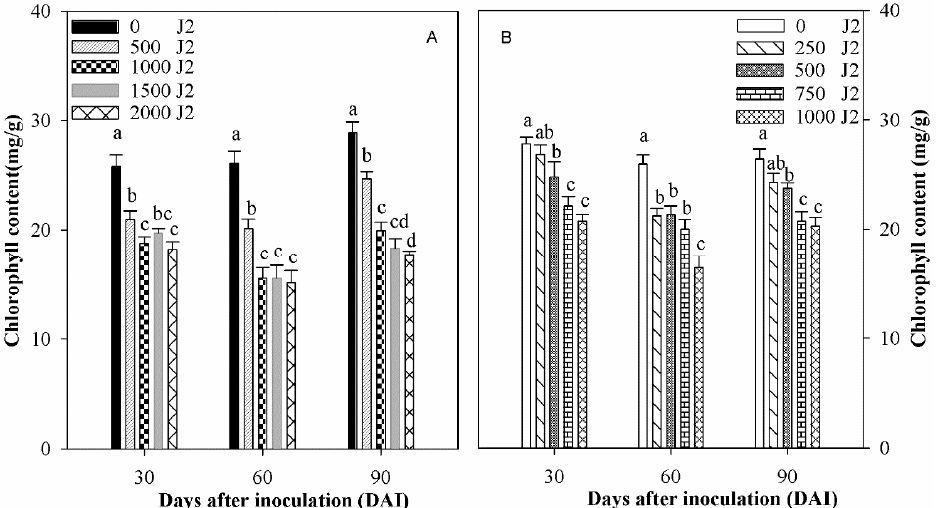
Figure 2. Chlorophyll content of rice leaf during 30-90 DAI with different inoculum densities of M. graminicola J2. ( A ): chlorophyll contents of rice leaf in the first experiment; ( B ): chlorophyll contents of rice leaf in the second experiment. Note: different lowercase letters on the same date indicate significant difference at p < 0.05 level according to LSD.